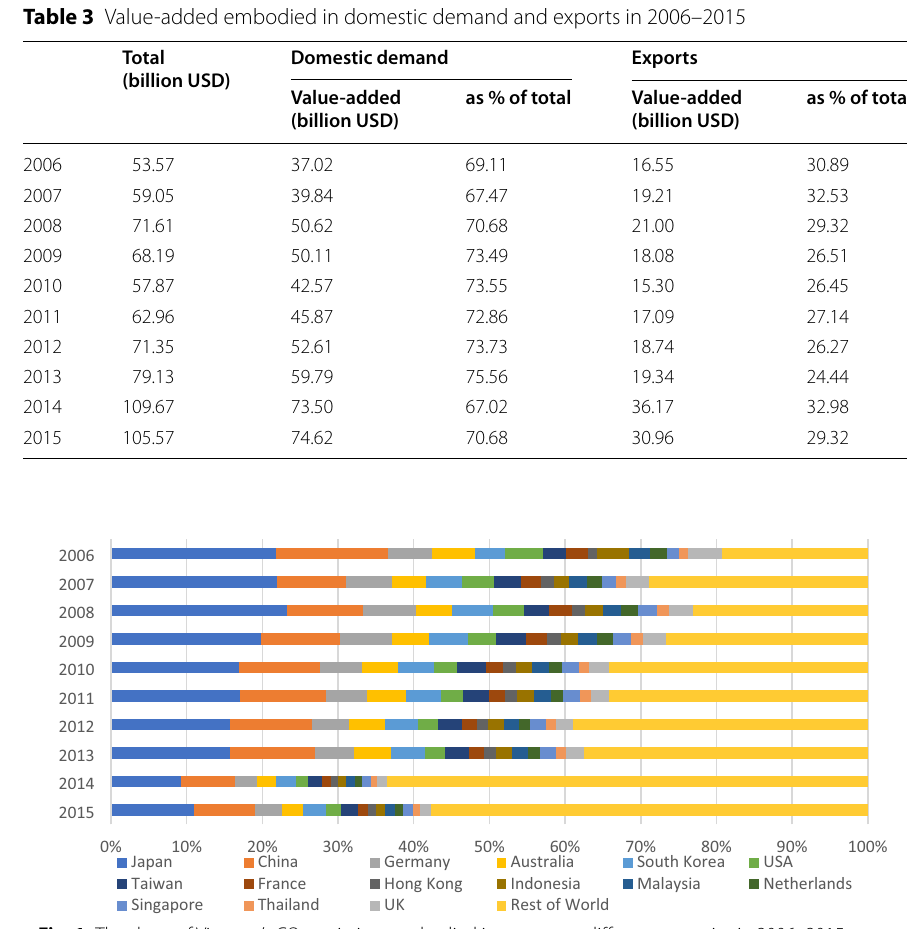
Fig. 1 The share of Vietnam’s CO 2 emissions embodied in exports to different countries in